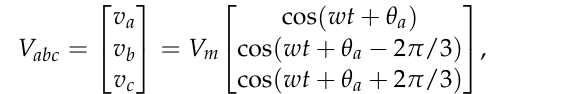
Figure 2. Clarke transformation [28]: ( a ) 𝑎𝑏𝑐 representation and ( b ) 𝛼𝛽 representation. The three-phase voltages of a balanced network are given by Equation (1):